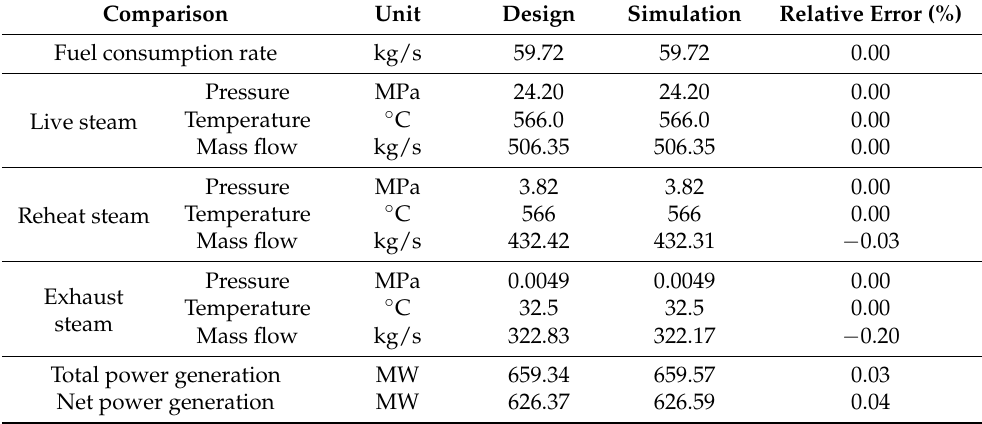
Table 9. Comparison between the simulation and design values of CFPU under 100% rated output load. Comparison Unit